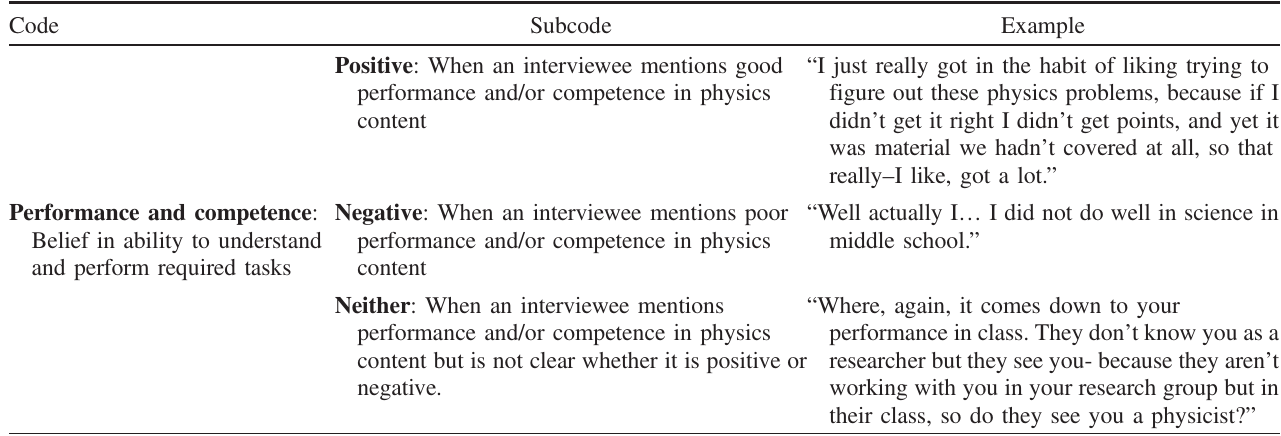
TABLE VI. Details of our competence and performance construct code definitions. This includes the definition of the main construct, as well as the definitions of each subcode and example from the interviews of Cara, Jeff, Cindy, or Owen. Code